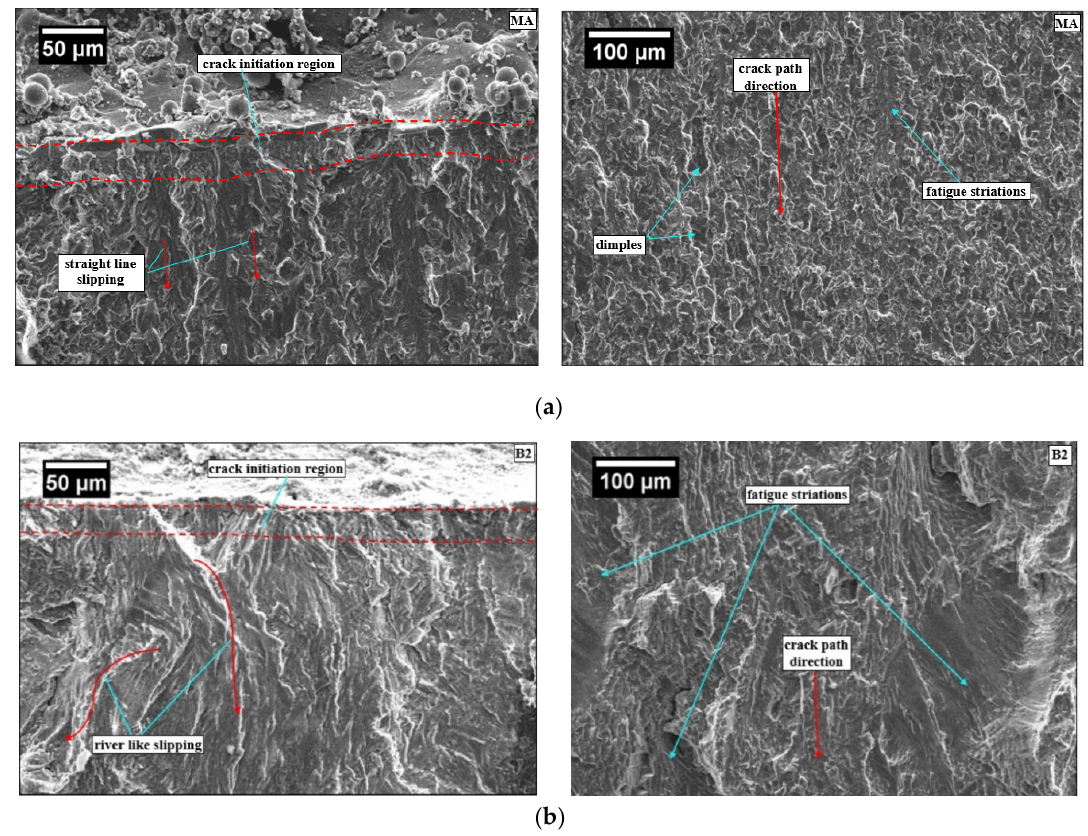
Figure 7. SEM fractography image of Ti-6Al-4V ELI for ( a ) MA FCP specimen and ( b ) B2 FCP specimen.